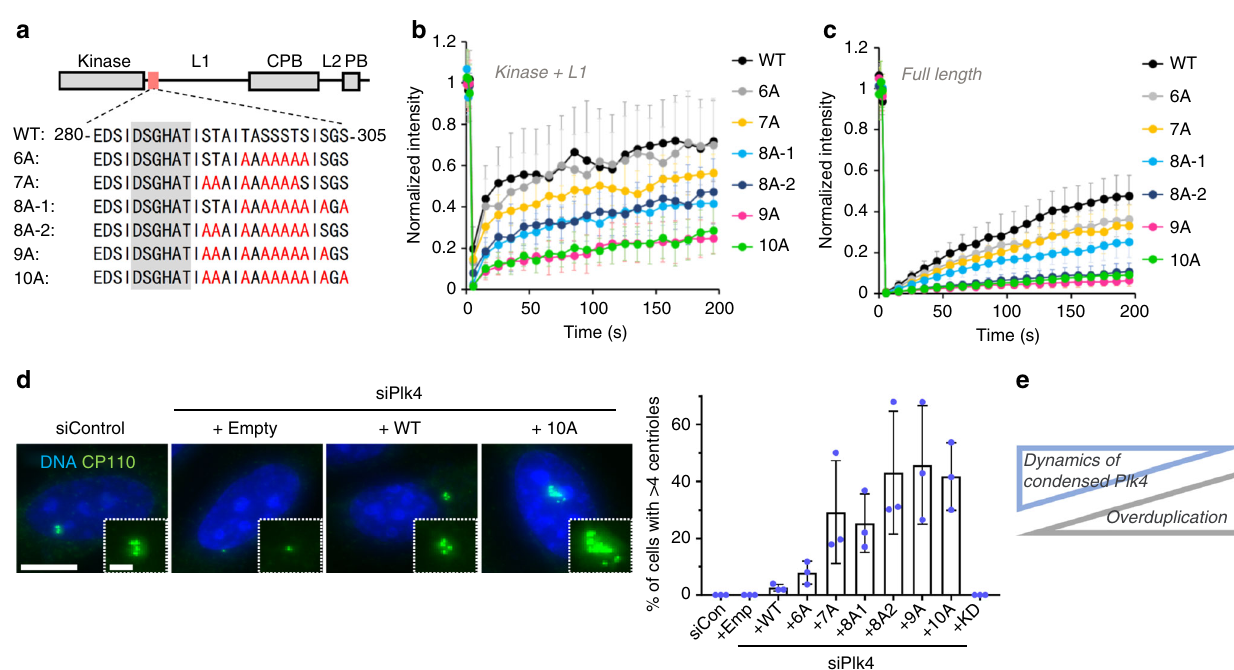
Fig. 3 Condensation properties of Plk4 regulate centriolar copy number. a Amino acid sequence of mutation sites in Plk4. Red letters, mutation sites; Gray background, degron motif. b FRAP analysis of cytoplasmic GFP-Plk4 (Kinase + L1) condensates ( b ) and centriolar GFP-Plk4 (Full length) ( c ) in HeLa cells ( n = 12 and 13 cells, respectively). For b and c , intensities were normalized with the average of three pre-bleach signals. Graph shows mean ± SD from two ( b ) or three ( c ) independent experiments. d Centriole over-duplication assay. Plk4 (Full length)-3xFLAG was exogenously expressed under the CMV mutant promoter in siPlk4-treated HeLa cells. Cells were transfected with siRNA (24 h) and then with plasmid (48 h). Cells were stained with anti-CP110 antibodies as a centriole marker. Scale bar, 10 μ m; inset, 2 μ m. Percentages of cells which have >4 CP110 foci were calculated. Graph represents mean percentages ± SD (siControl n = 146, siPlk4 + Emp n = 159, siPlk4 + WT n = 153, siPlk4 + 6A n = 153, siPlk4 + 7A n = 166, siPlk4 + 8A1 n = 155, siPlk4 + 8A2 n = 148, siPlk4 + 9A n = 151, siPlk4 + 10A n = 157, siPlk4 + KD n = 151 cells) from three independent experiments. e Summary of the correlation between the condensed Plk4 dynamics and frequencies of centriole overduplication. Source data are provided as a Source Data fi